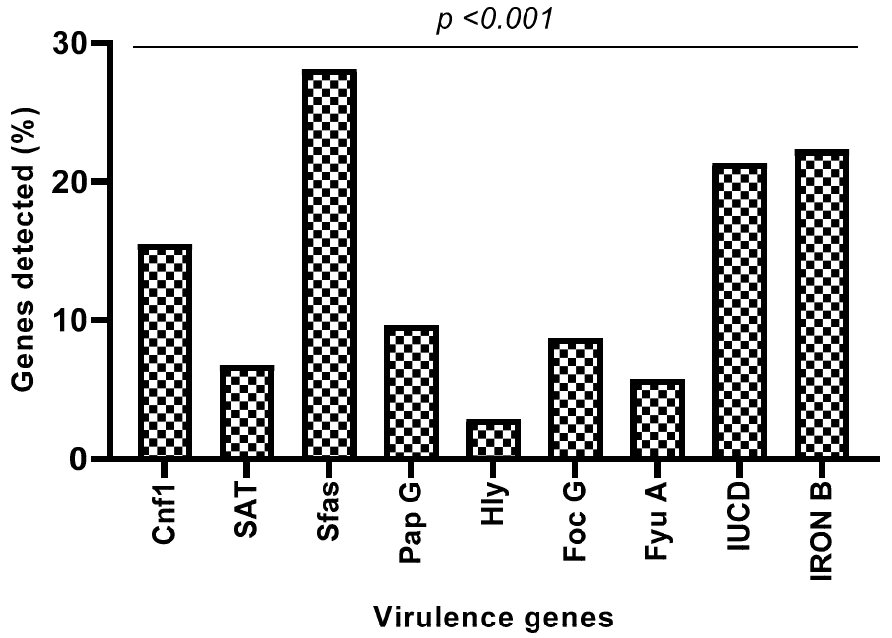
Figure 5. Proportion of genes sought in all strains. Cnf1 : cytotoxic necrotizing factor type 1, SAT : secreted autotransporter toxin, Sfas : S-fimbriae adhesin, Pap G: adhesin P-fimbria, Hly : hemolysin RTX, Foc G: F1C fimbrial adhesin, Fyu A: yersiniabactin outer membrane receptor, IUCD : aerobactin biosynthesis receptor, Iron B: salmochelin outer membrane receptor.